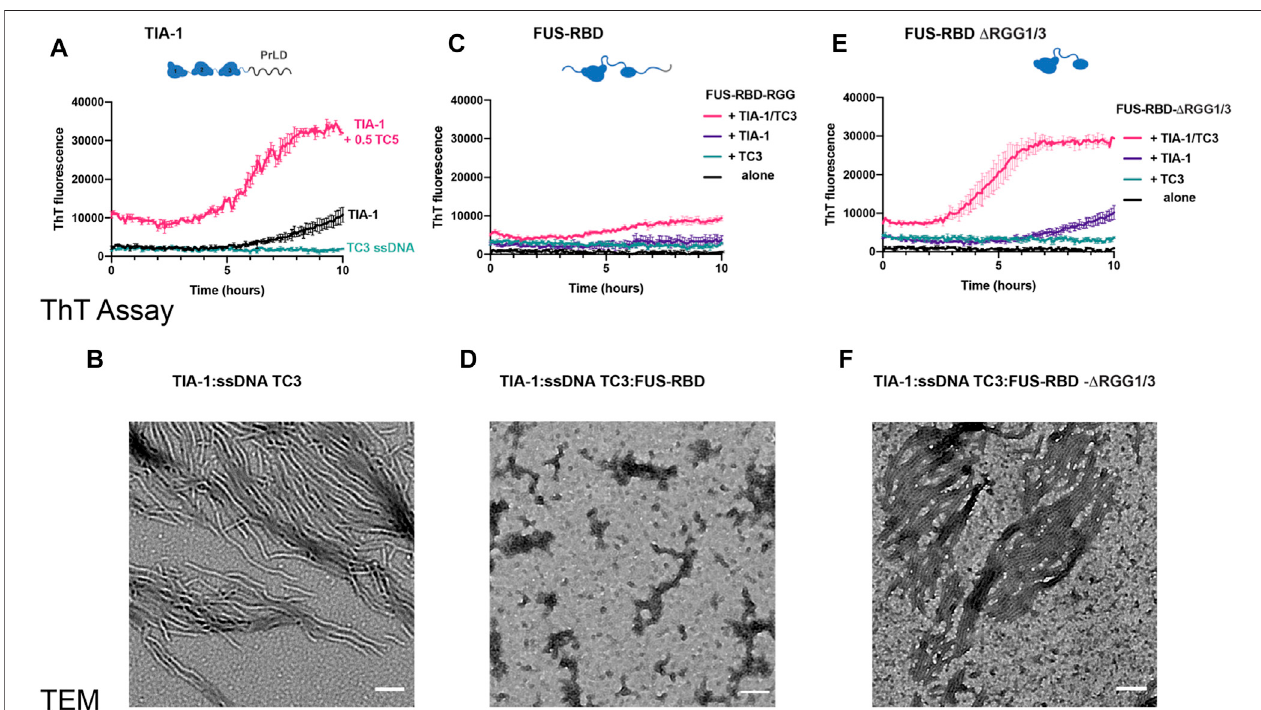
FIGURE5| FUSRBDinhibitsnucleicacidinducedTIA-1 fi brilformation via RGGIDRs (A) Thio fl avinT(ThT) fl uorescenceassaymonitoring fi brilformationof2.5 μ M TIA-1 alone or in presence of 0.5 μ M ssDNA TC3. (B) TEM of 2.5 μ M TIA-1, 0.5 μ M ssDNA TC3. (C) ThT fl uorescence assay of 2.5 μ M FUS-RBD-RGG alone and in combinations with 2.5 μ M TIA-1, 0.5 μ M ssDNA TC3. (D) TEM 2.5 μ M TIA-1, 0.5 μ M ssDNA TC3, 2.5 μ M FUS-RBD-RGG. (E) ThT fl uorescence assay of 2.5 μ M FUS- RBD-short alone and in combinations with 2.5 μ M TIA-1, 0.5 μ M ssDNA TC3. (F) TEM of 2.5 μ M TIA-1, 0.5 μ M ssDNA TC3, 2.5 μ M FUS-RBD-short.